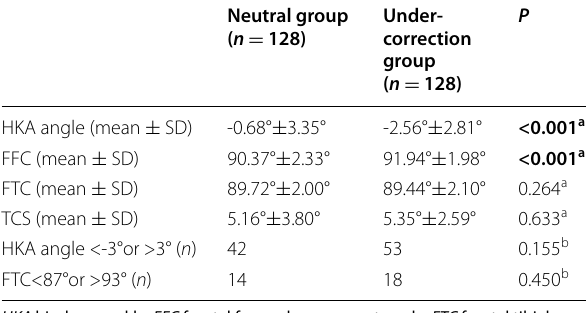
HKA hip-knee-ankle, FFC frontal femoral component angle, FTC frontal tibial component angle, TCS tibial component slope angle. For HKA angle, varus was negative and valgus was positive; for TCS, retroversion was positive and anteversion was negative a stands for student t -test b stands for chi-square test; data are recorded as number or mean deviation